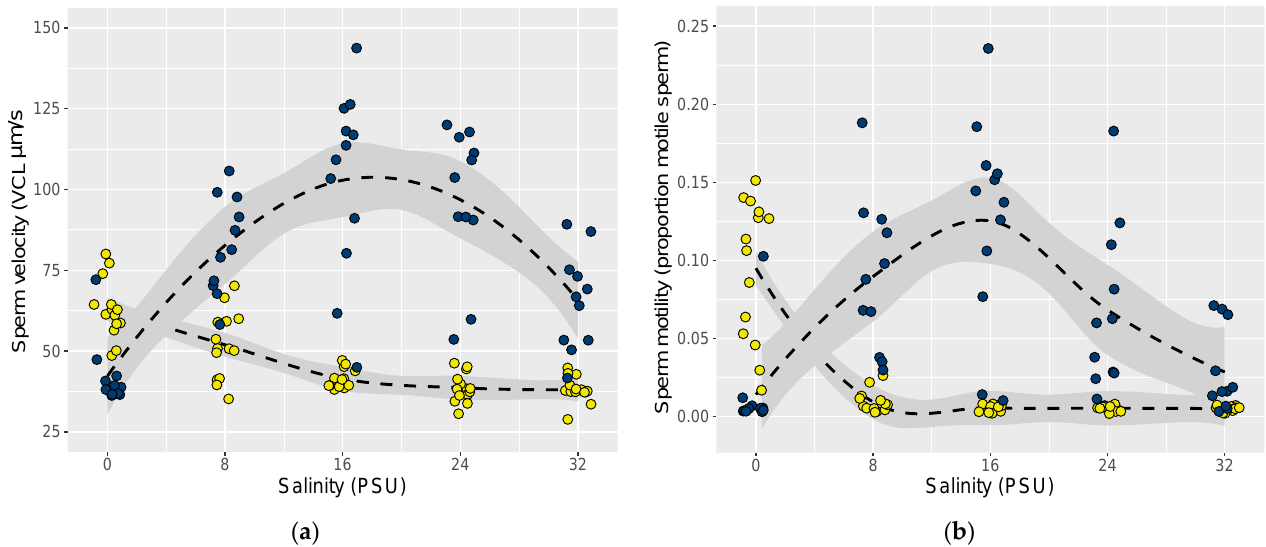
Figure 2. Sperm traits of the invasive fish Neogobius melanostomus originating from the ancestral Black Sea site of Sozopol (dark blue) and the ancestral freshwater river Danube (yellow) (see Supplementary Table S1 for coordinates). Panel ( a ) shows sperm velocity and panel ( b ) shows sperm motility across a salinity gradient of freshwater (0 PSU) to North Sea coastal salinity conditions (32 PSU). Individual data points have been jittered horizontally around each test salinity. Lines show locally weighed scatterplot smoothings (loess smooths) using weighted least squares of the model (response ~ origin x salinity), shaded area shows 95% confidence intervals, both fitted with the ggplot2 package in R.